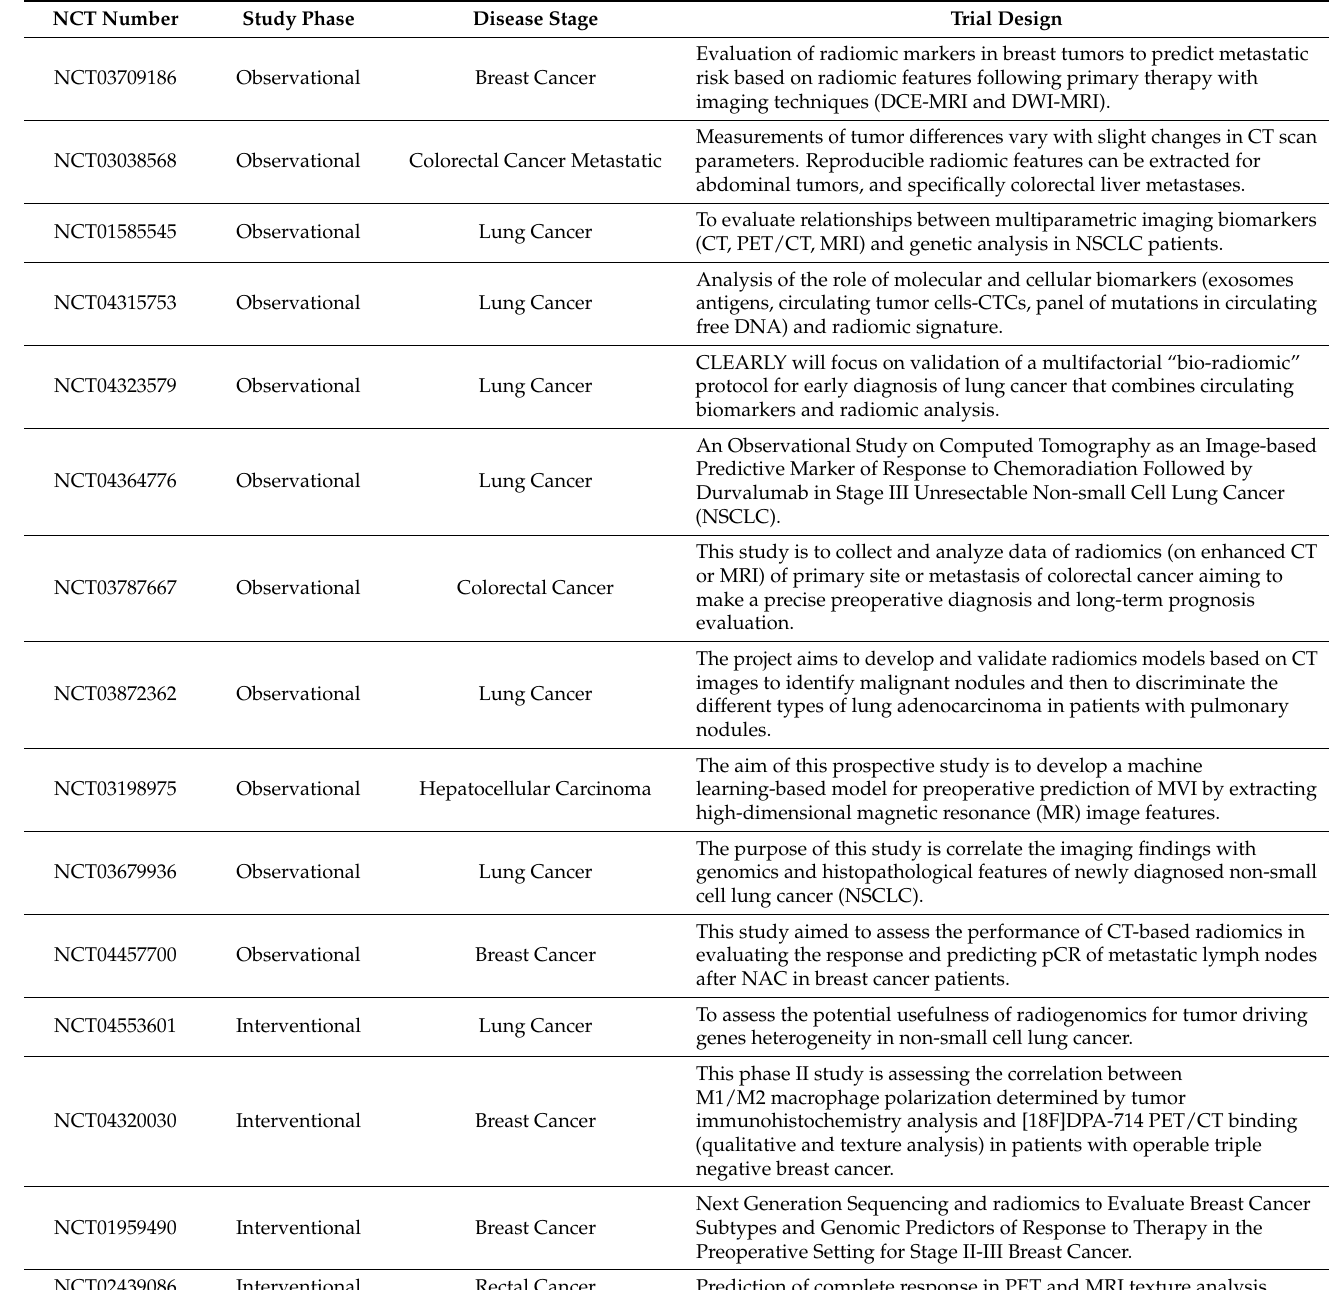
Table 1. Registered Clinical trials investigating Radiomics approach in